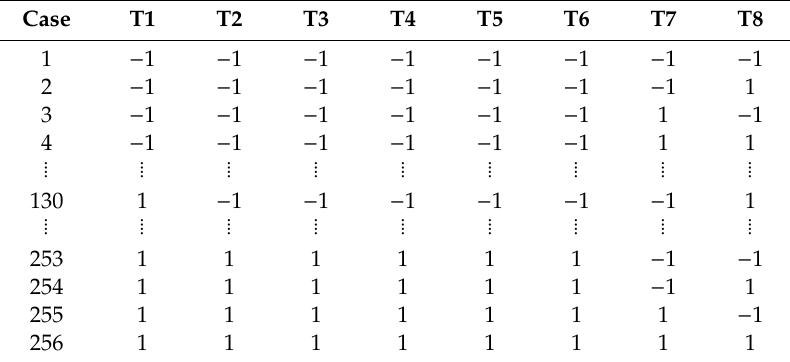
Table 4. Regression coefficients of a response surface model. Table 11. Factorial design for applicable technologies.